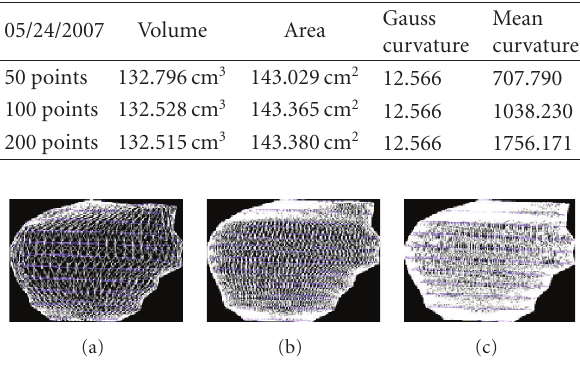
Figure 34: Patient 1. Evolution of the tumor with respect to time.